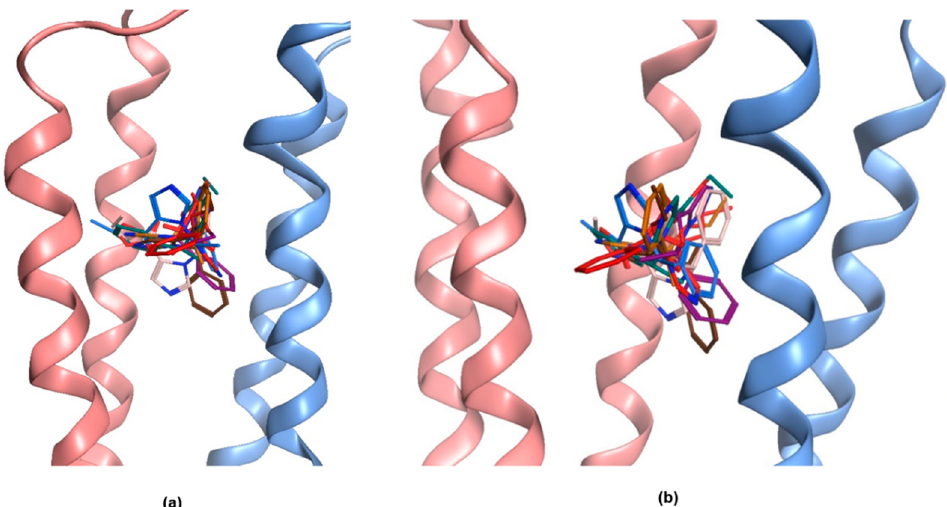
Figure A2. Diversity of etomidate binding poses in 6HUP. Of the top 100 poses (GoldScore ranking), consensus scoring and ligand flexibility suggests that the diversity of the posing space is very high and experimentally guided constraints or a higher level of computational theory is needed. The diversity of the posing space is illustrated based on the most diverse solutions among the top 20 from two scoring functions. All poses display a high overlap of ligand–protein interactions with the diazepam present in this site in 6HUP. ( a ) Front view; ( b ) side view.